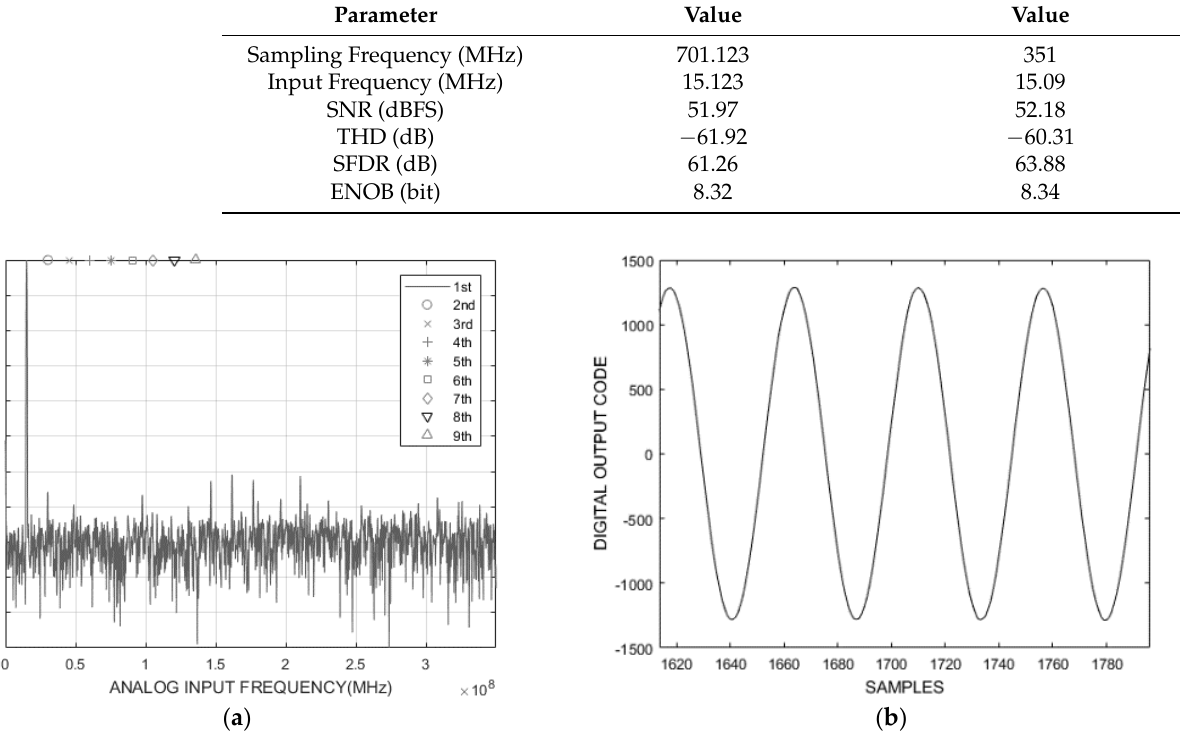
Figure 15. ( a ) Spectrogram of the actual test; ( b ) Actual test recovered time domain